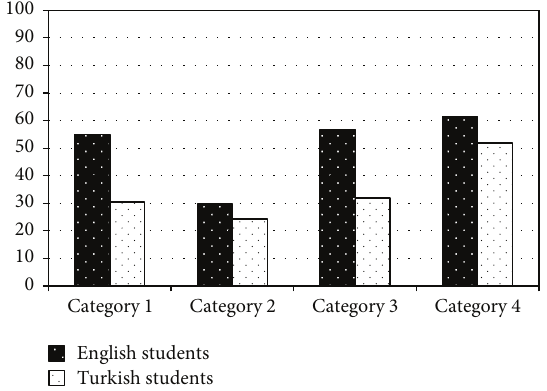
Figure 1: The percentages of English and Turkish students’ who provided correct responses to both tiers of test items relating to the four conceptual